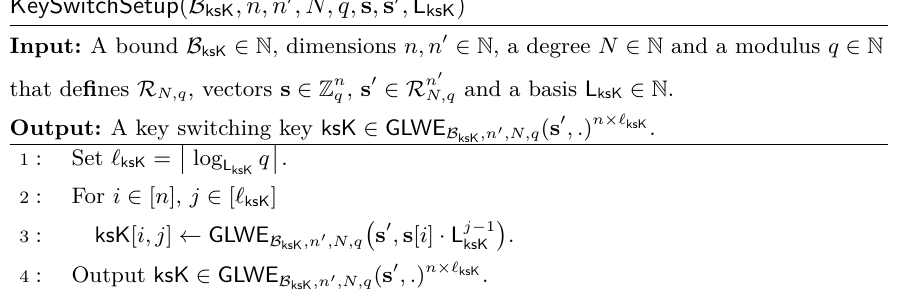
Figure 8: Key switching setup